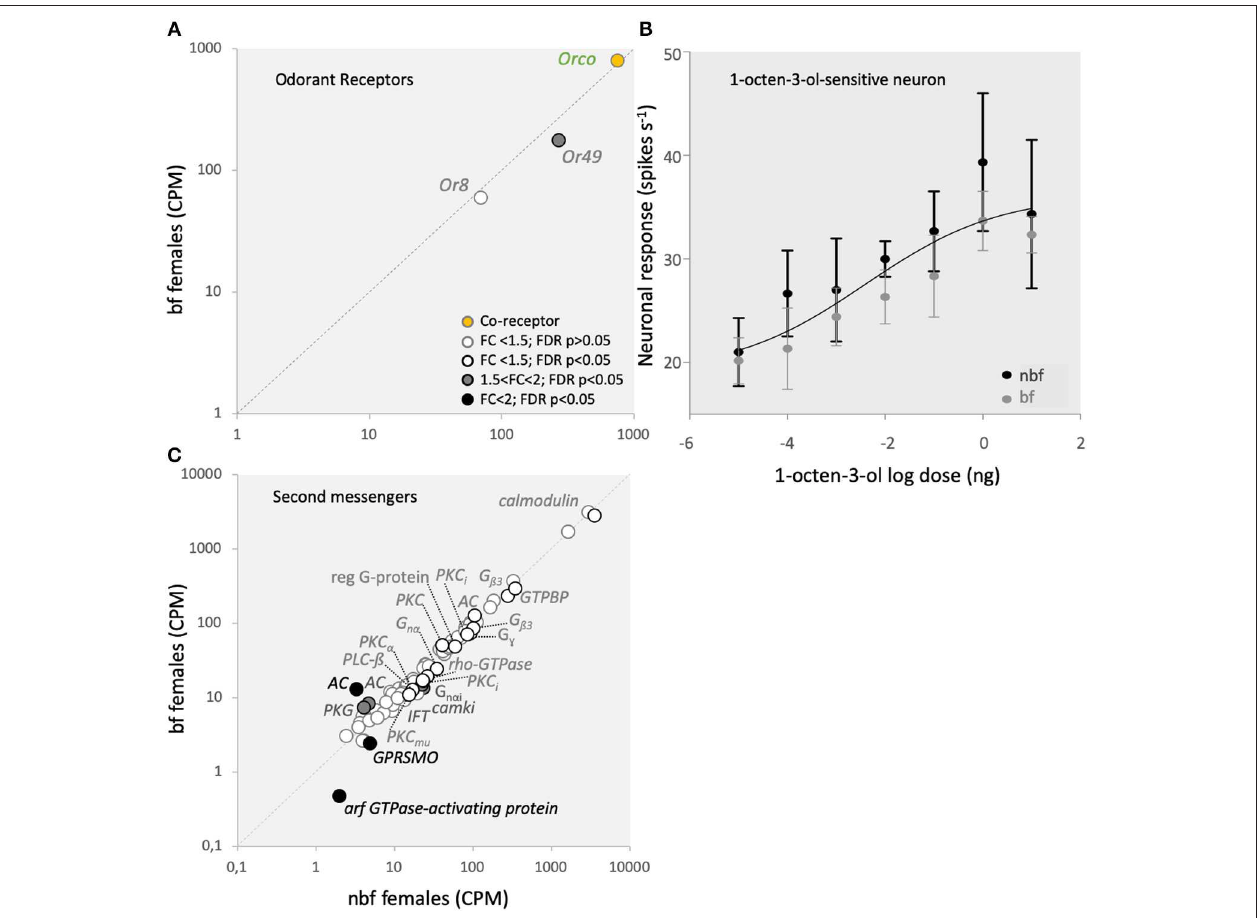
FIGURE 4 | Odorant receptor (Or) mediated signaling. (A) Transcript regulation in the maxillary palps of blood fed (bf) and non-blood fed (nbf) Aedes aegypti females of the co-receptor, Orco (orange-filled circle), the ( R )-1-octen-3-ol-sensitive Or8, and the orphan receptor Or49. (B) Response of the ( R )-1-octen-3-ol-sensitive neuron to various concentrations of ( R )-1-octen-3-ol. The trendline represents the non-linear regression among all responses and concentrations. (C) Differential regulation of second messenger gene expression in the maxillary palps. Transcripts that exhibit significant differences in abundance (Kal’s test; FDR P < 0.05) are denoted according to their fold change (FC); FC > 2 in black-filled circles; 1.5 < FC < 2 in gray-filled circles; and FC < 1.5 in unfilled circles. The gray dotted line indicates a hypothetical equal transcript abundance between the states. Chimerin (rho-GTPase-activating protein; rho-GTPase ); guanylate cyclase ( GC ); nucleolar GTP-binding protein ( GTPBP ); cGMP-dependent protein kinase ( PKG ); cAMP-dependent protein kinase type ii regulatory subunit ( PKA ); smoothened G-protein coupled receptor ( GPRSMO ); intraflagellar transport protein ( IFT ); G-protein, gamma-subunit ( G γ ); GTP-binding protein alpha subunit ( Gn α ); GTP-binding protein (i) alpha subunit ( Gn α i ); protein kinase C inhibitor ( PKCi ); phospholipase c beta ( PLC-ß ); G-protein β 3 ( G β 3 ); calcium/calmodulin-dependent protein kinase type 1 ( camki ); regulator of g protein signaling ( reg G-protein ); protein kinase C ( PKC ; PKC mu ; PKC α ); adenylate cyclase ( AC );